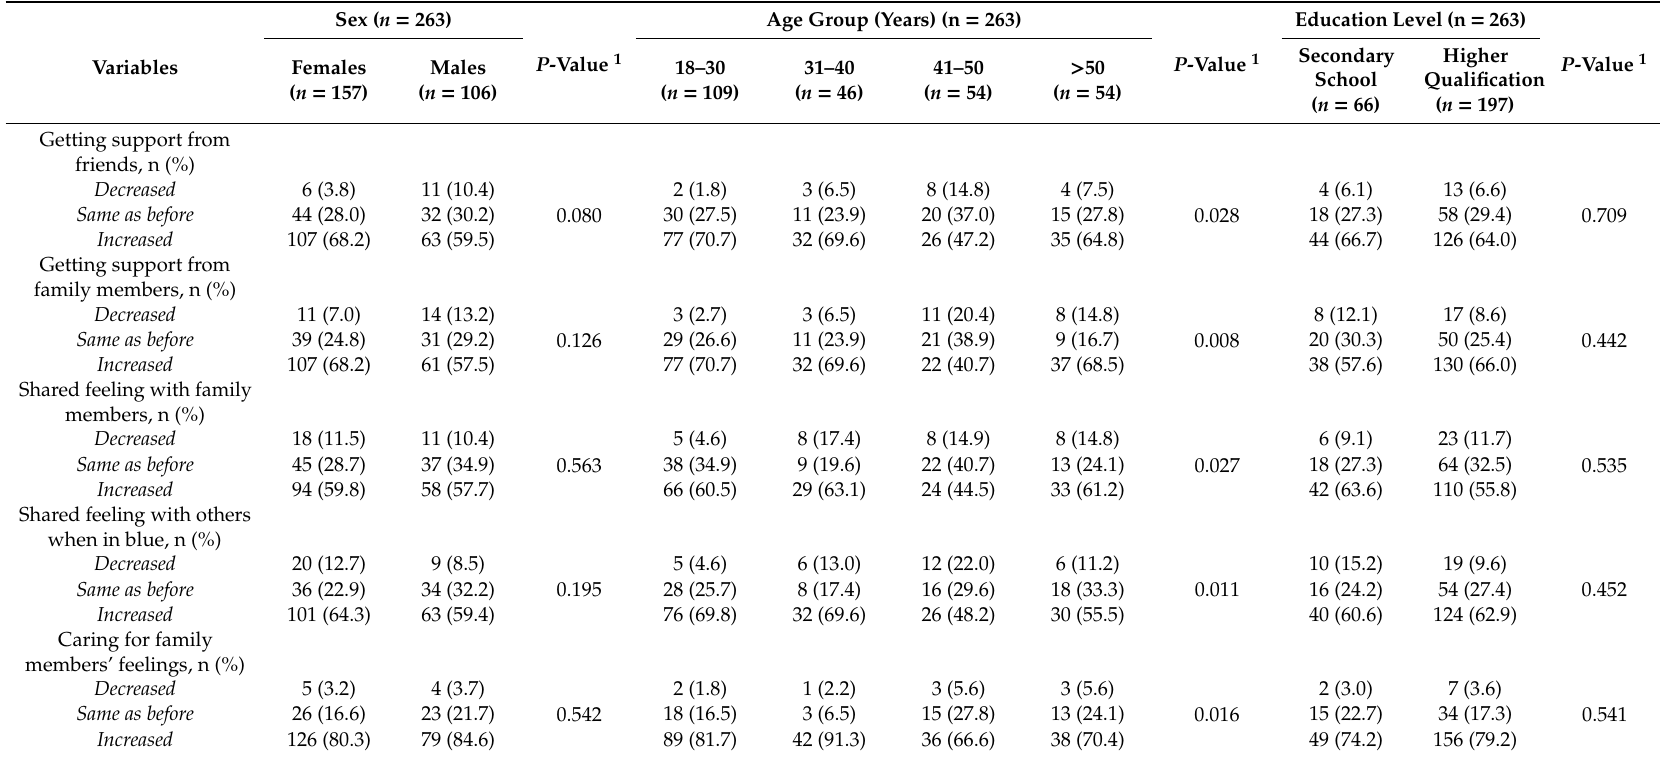
Table 4. Changes in family and social support by demographic